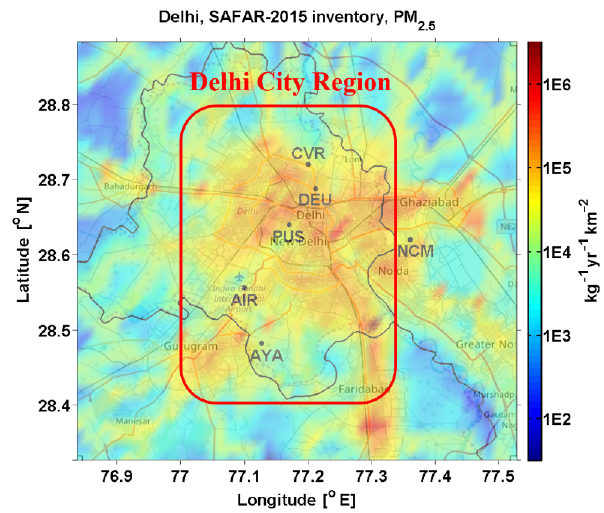
Figure 2. SAFAR inventory of total PM 2 . 5 emissions. The locations of measurement sites over Delhi are marked by black dots, and the Delhi city region is marked by a red box. This figure is modified from OpenSteetMap. © OpenStreetMap contributors 2019. Dis- tributed under a Creative Commons BY-SA